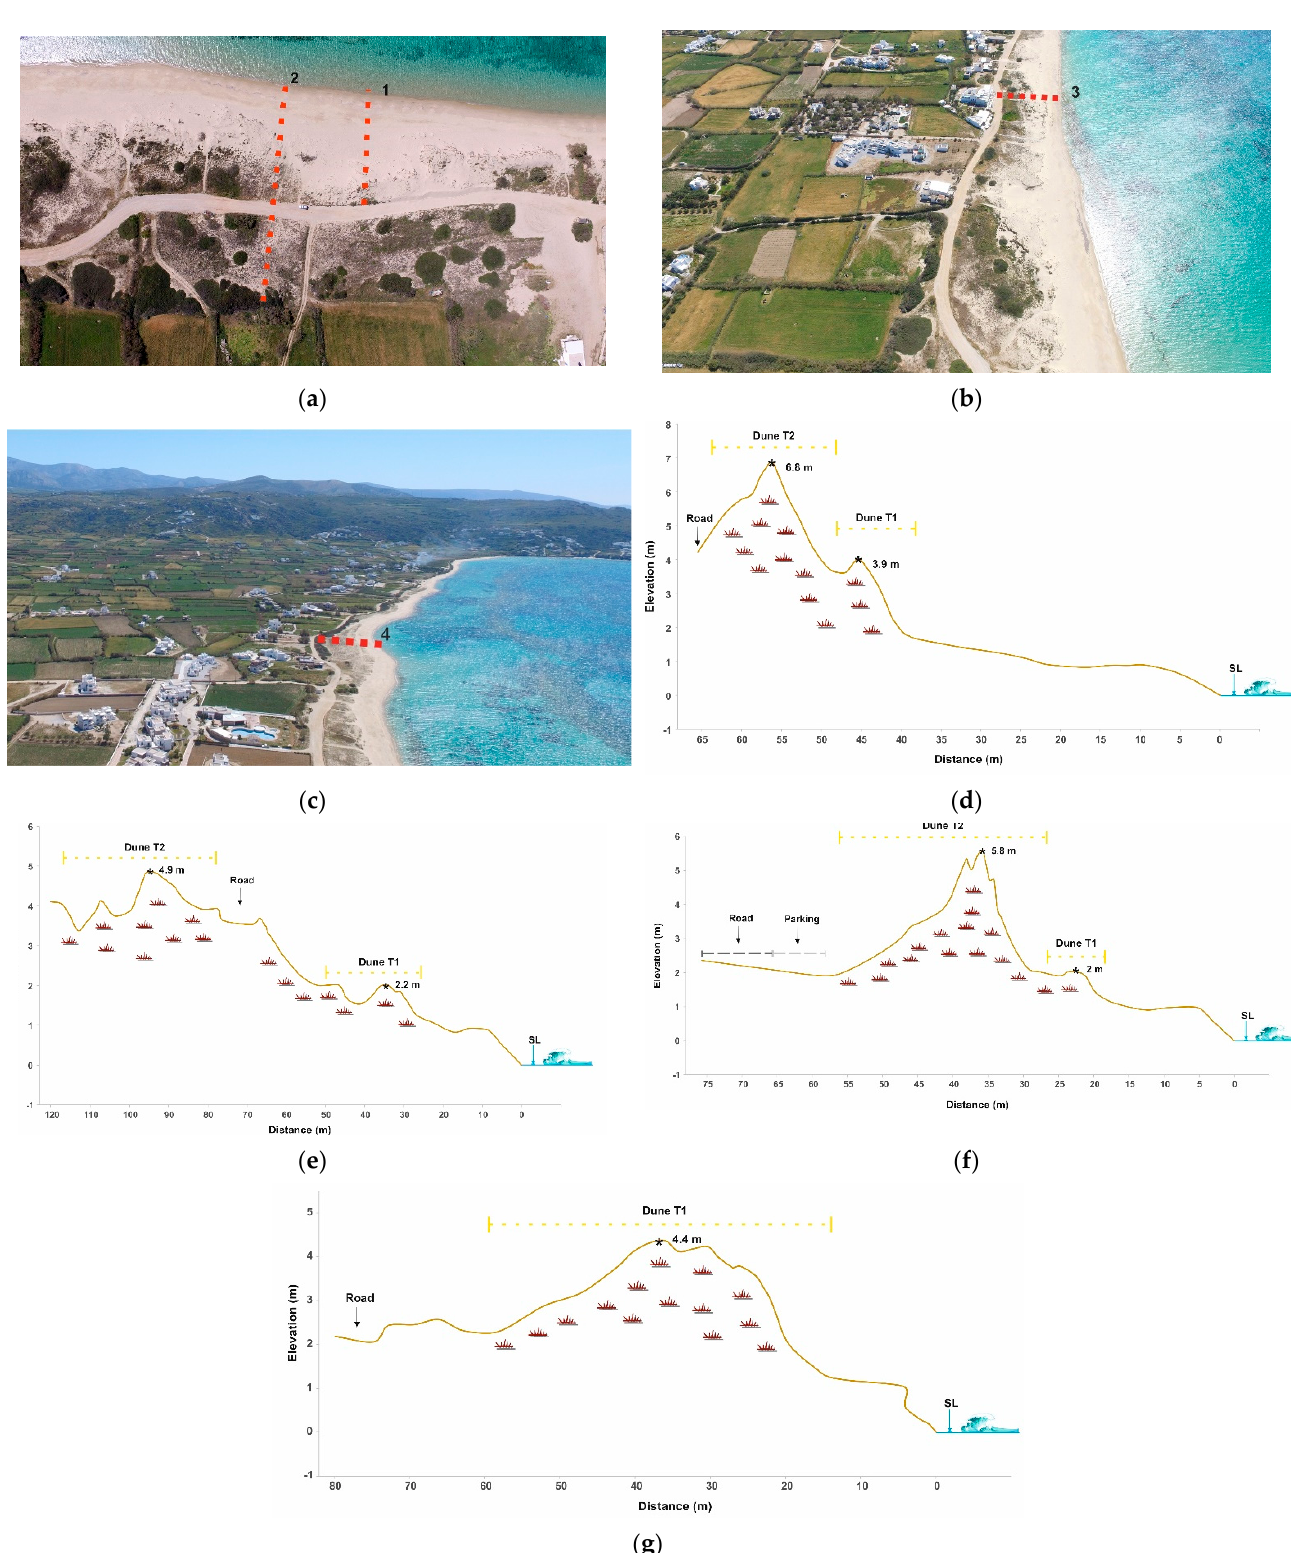
Figure 6. Aerial photographs of Plaka site, with the locations of ( a ) cross Sections 1 and 2; ( b ) cross Section 3 and ( c ) cross Section 4; ( d ) Sketches of cross section Plaka 1; ( e ) Plaka 2 ; ( f ) Plaka 3 and ( g ) Plaka 4.